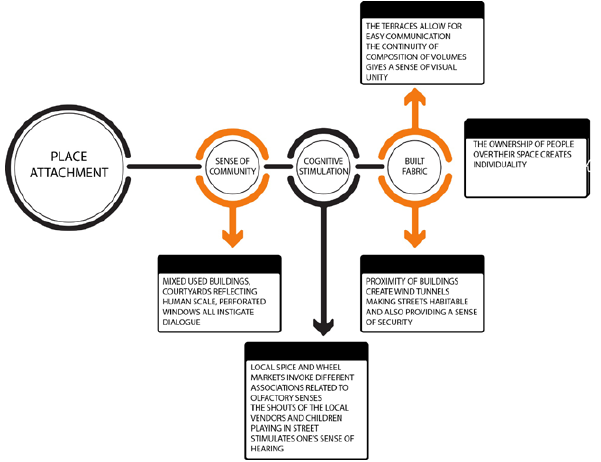
Figure 6. Characteristics of the walled city, which creates place attachment (Zahid,